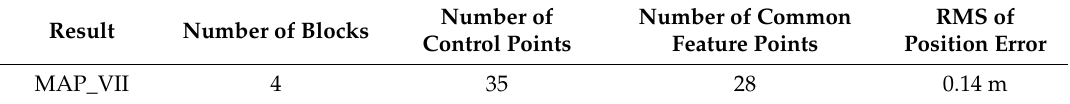
Figure 8. Distributed mapping result (MAP_VII). Table 3. Stitching accuracy of distributed mapping results.